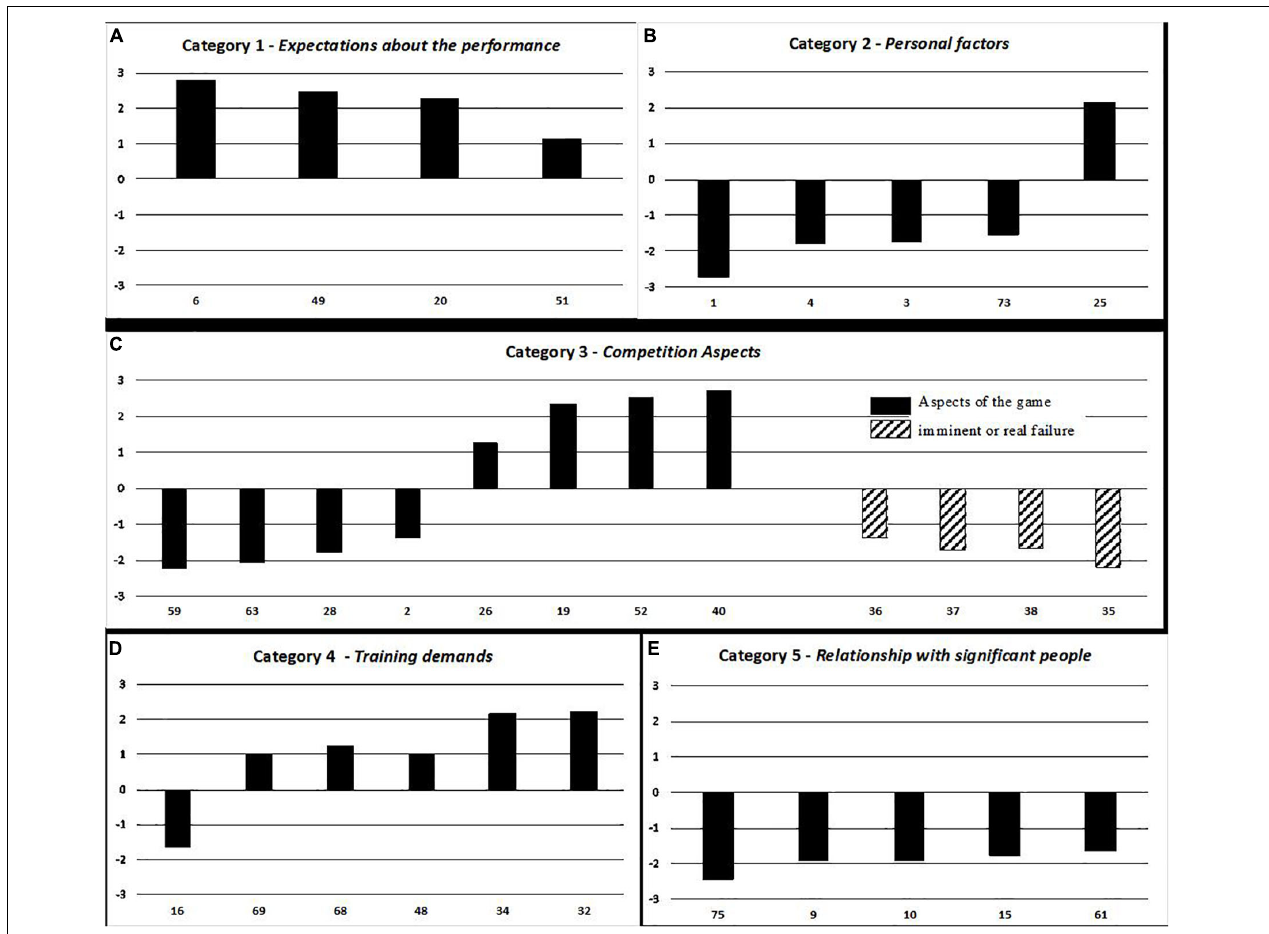
FIGURE 2 | List of soccer event stressors by categories of stress, Expectations about Performance (A) , Personal Factor (B) , Competition Aspects (C) , Training Demands (D) , and Relationship with Significant People (E)